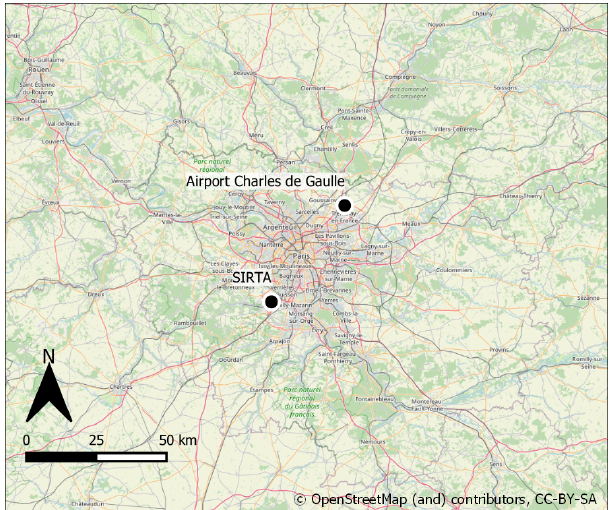
Figure 1. Location of the SIRTA supersite southwest of